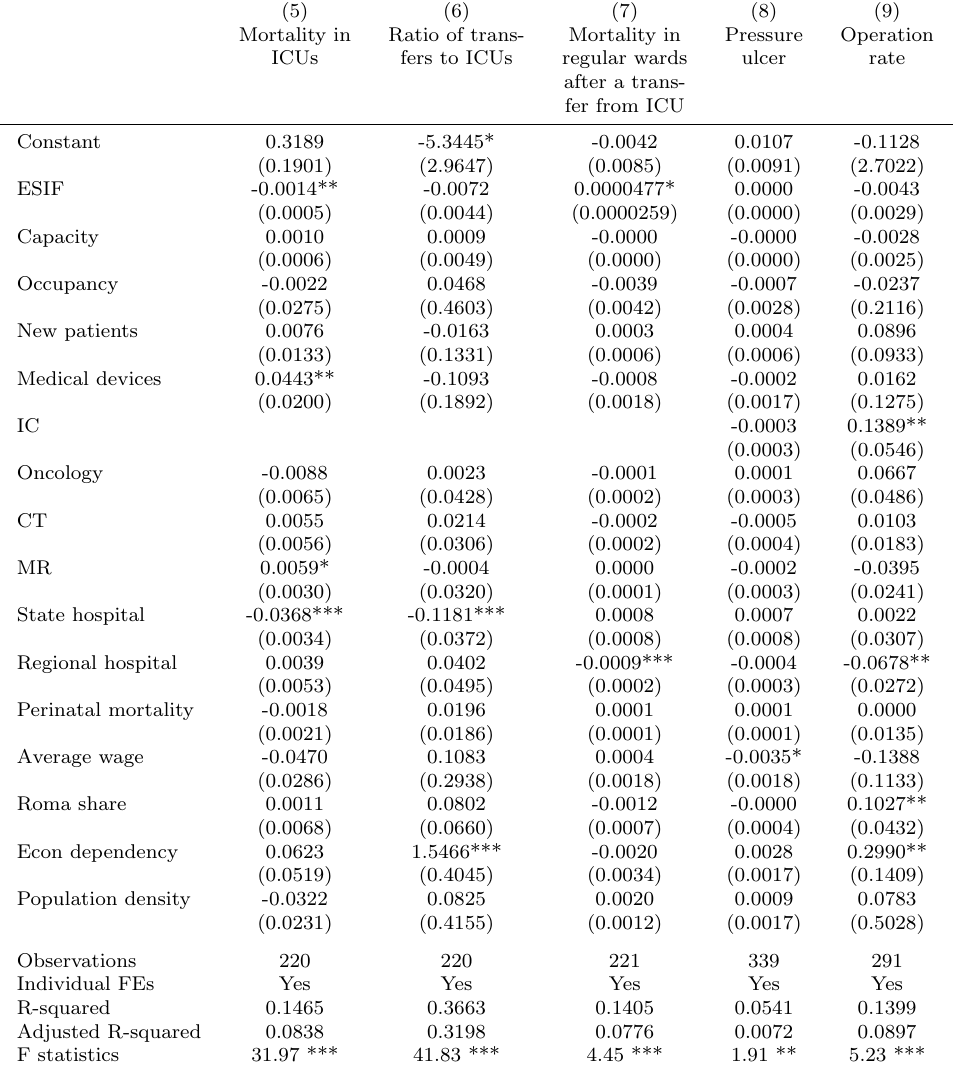
Table A.5: Contemporaneous effect of cumulative ESIF on the mortality rate in selected categories – full model (part